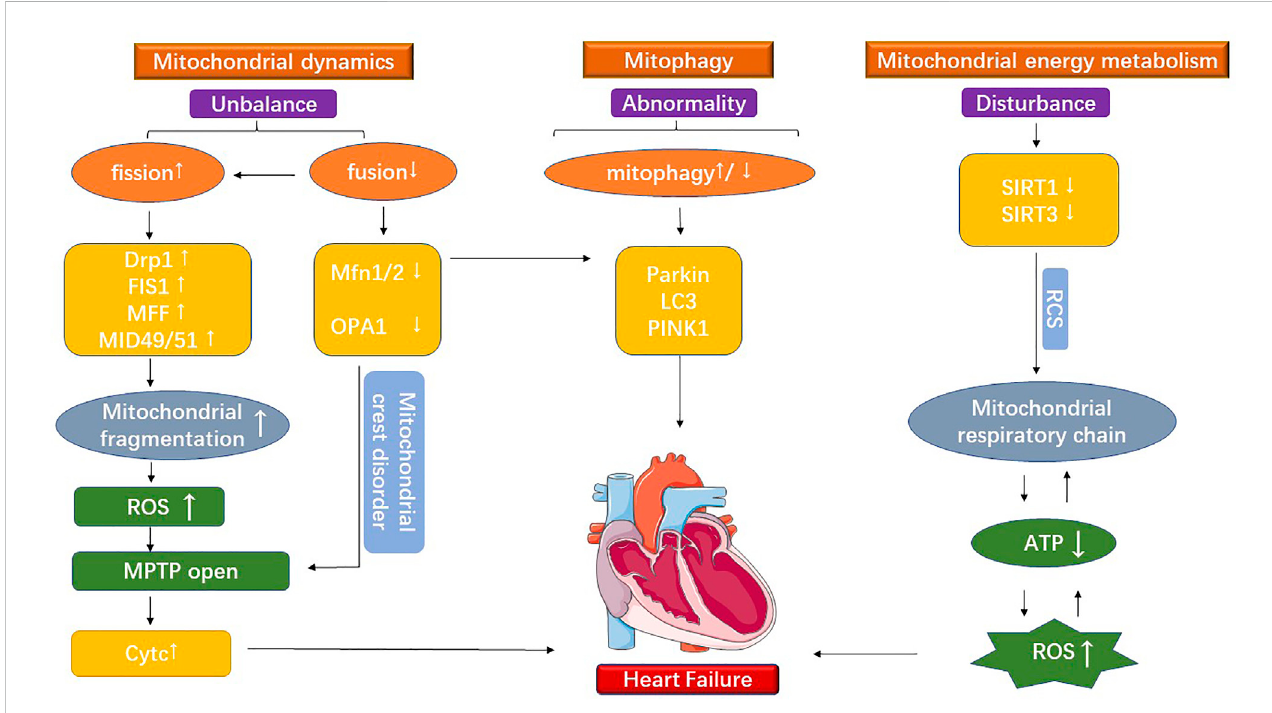
FIGURE 1 The fi gure shows the mitochondrial dysfunction under cardiovascular disease. It is divided into three main parts: mitochondrial division, mitochondrial fusion, and mitochondrial energy